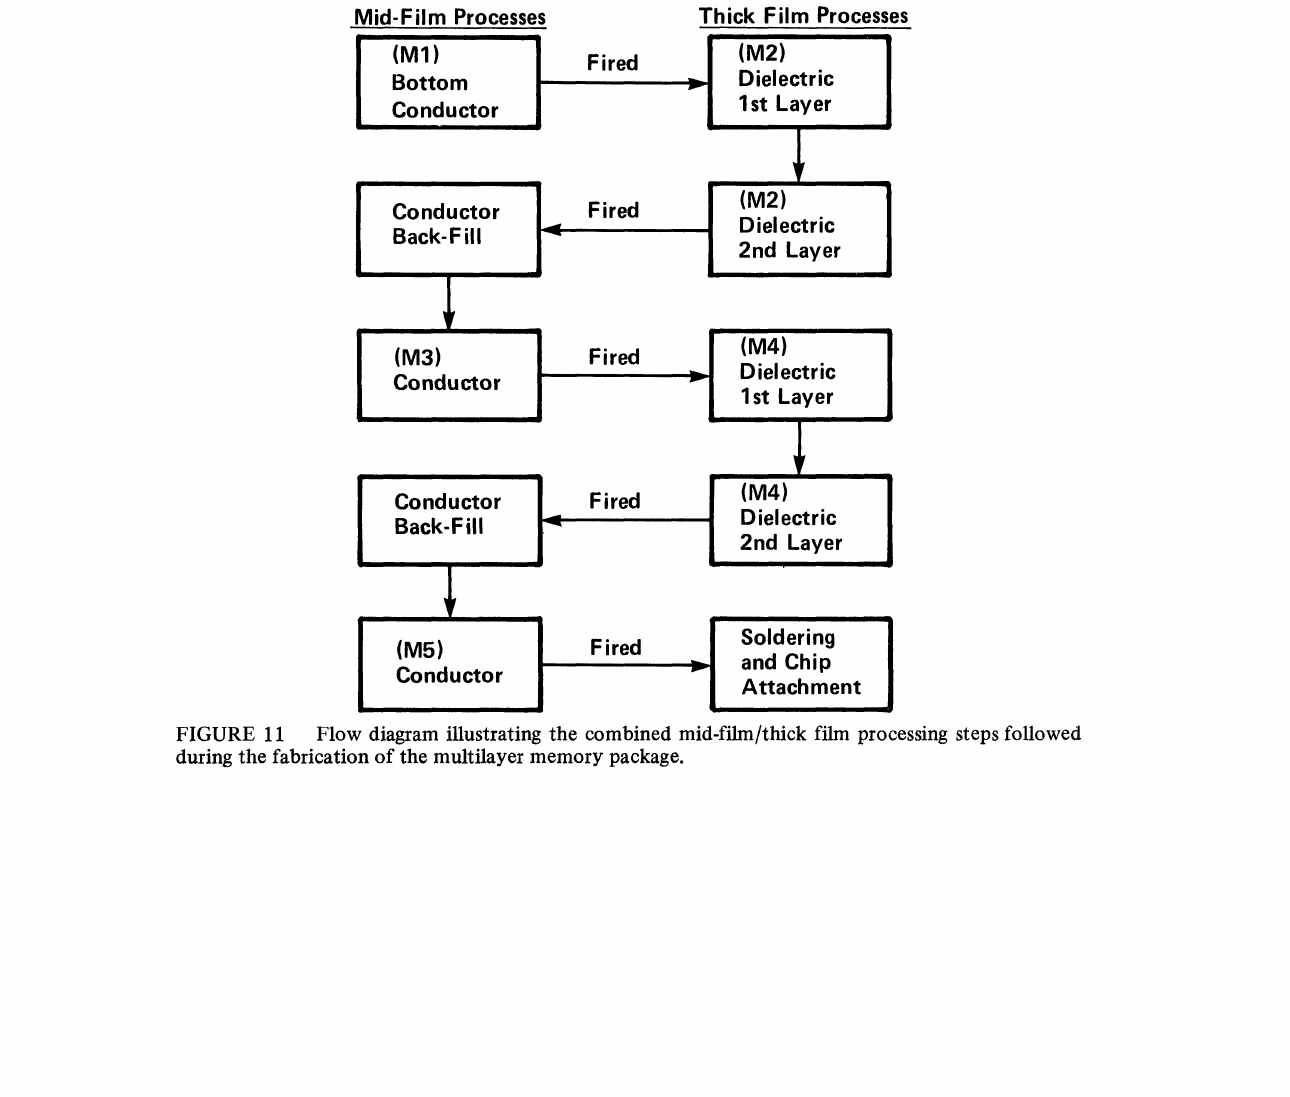
Flow diagram illustrating the combined mid-film/thick film processing steps followed during the fabrication of the multilayer memory